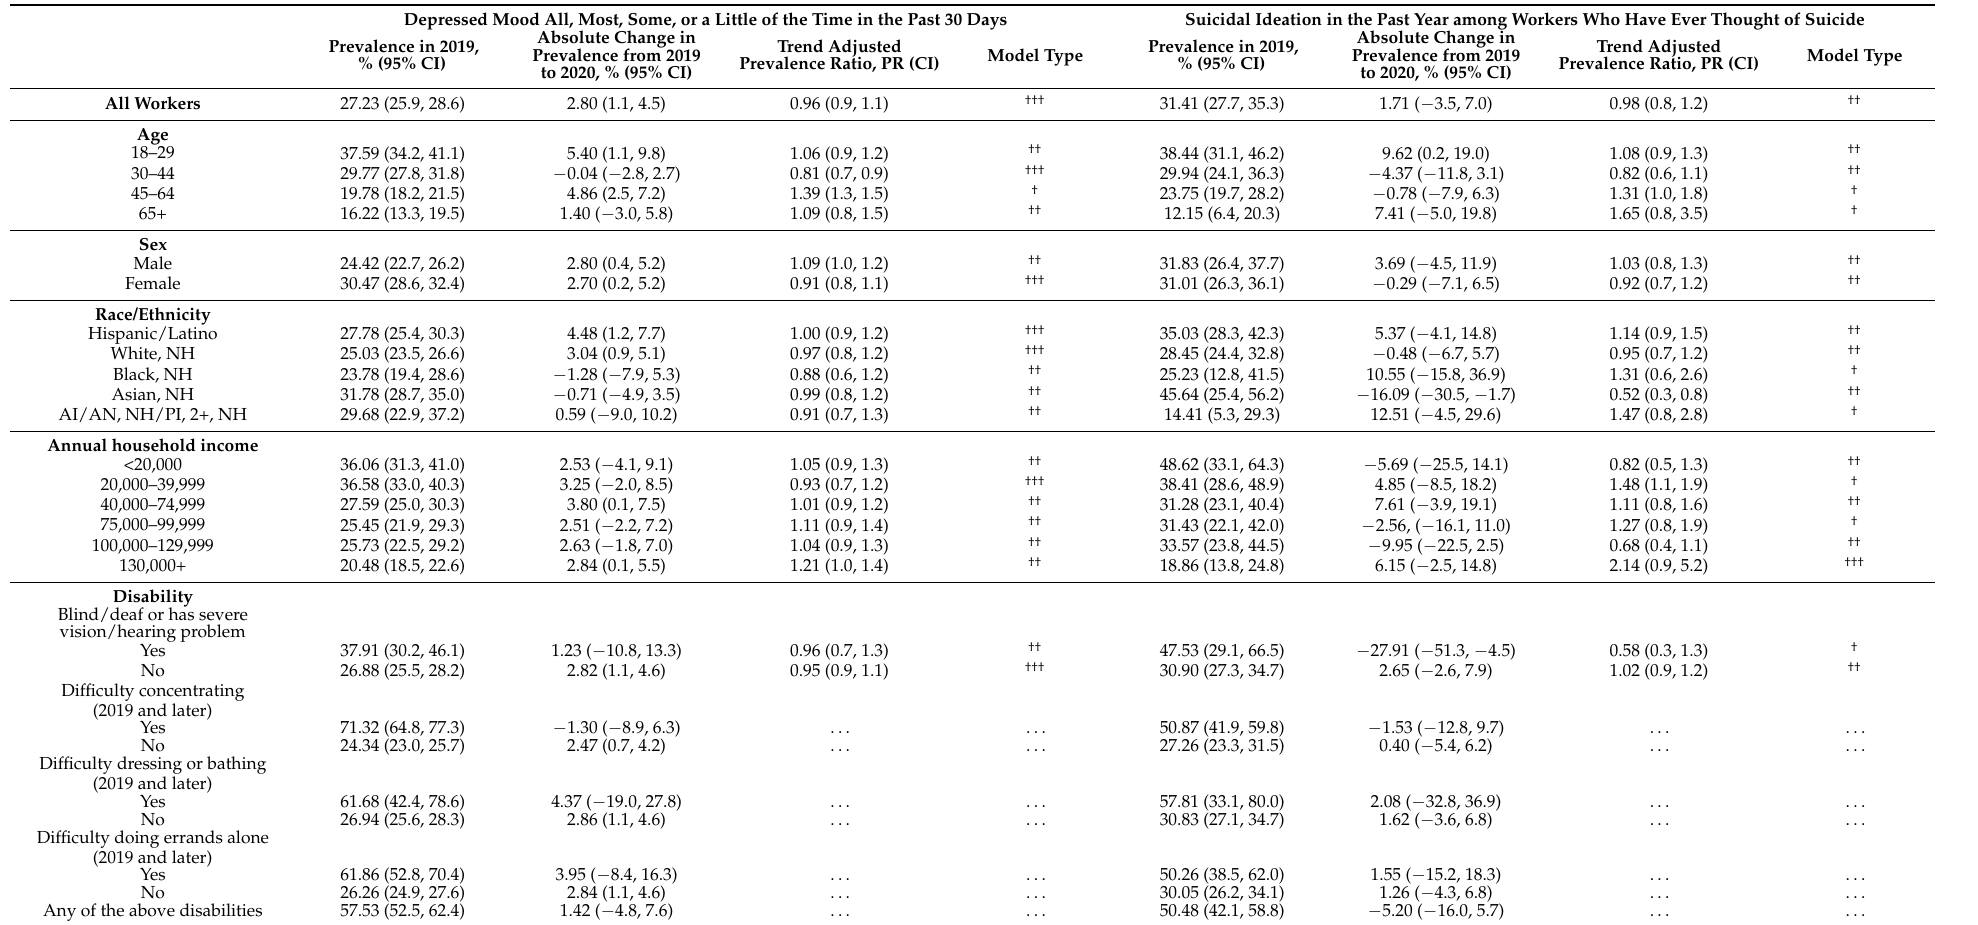
Table 2. Depressed mood and suicidal ideation in working adults. Depressed Mood All, Most, Some, or a Little of the Time in the Past 30 Days Suicidal Ideation in the Past Year among Workers Who Have Ever Thought of